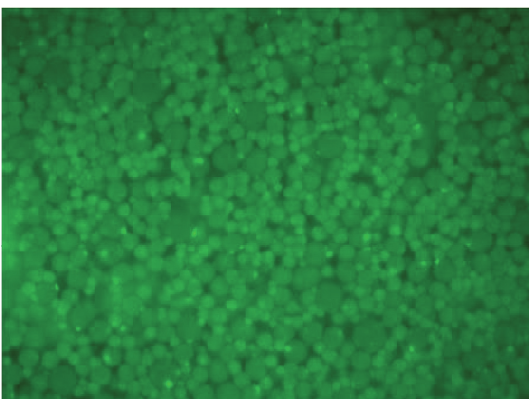
Figure 6: Micrograph of encapsulated salt emulsion.